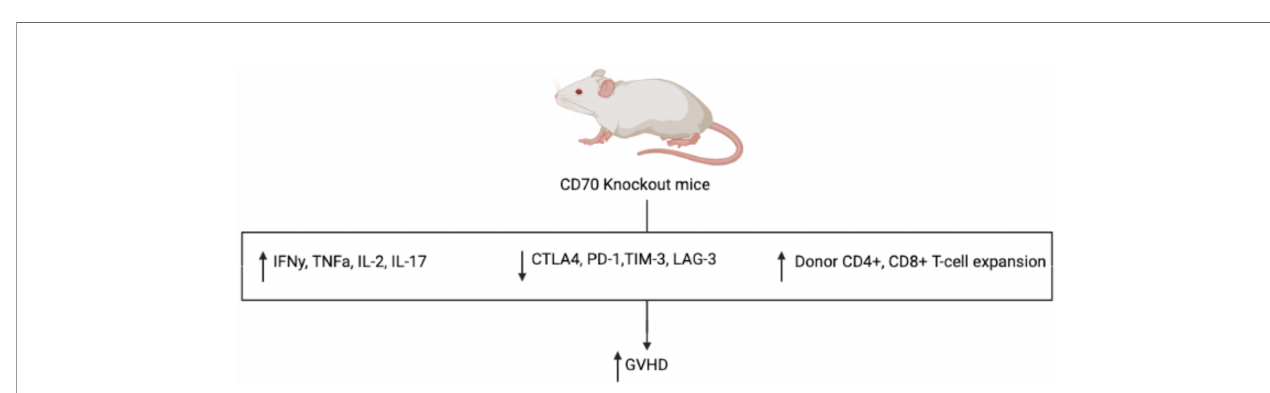
FIGURE 3 | Mechanism of increased GVHD in CD70 knockout mice. Compared to WT control, CD70 knockout mice have signi fi cantly more GVHD with increased in fl ammatory cytokines, decreased CPI expression, and increased expansion of donor